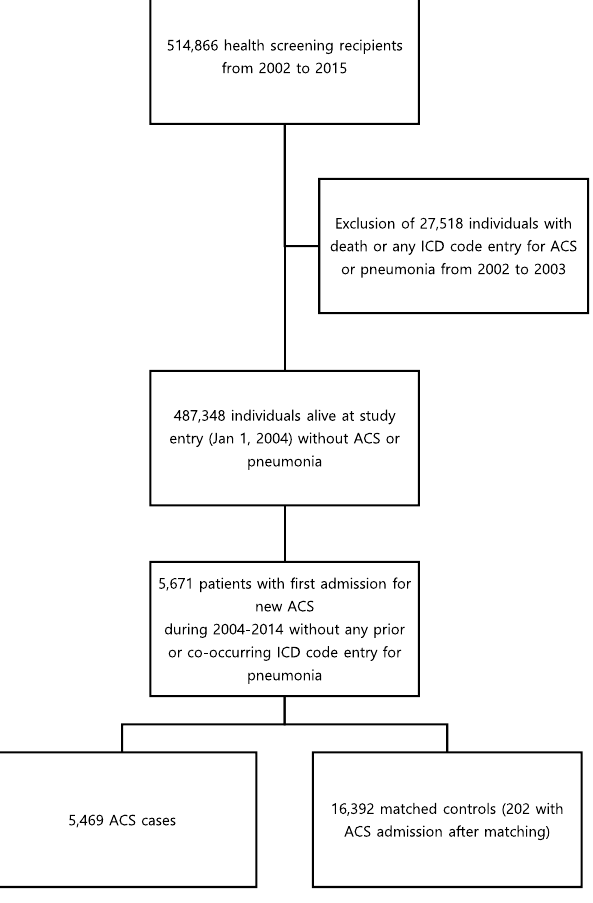
Figure 1. Construction of the study cohort dataset using incidence density